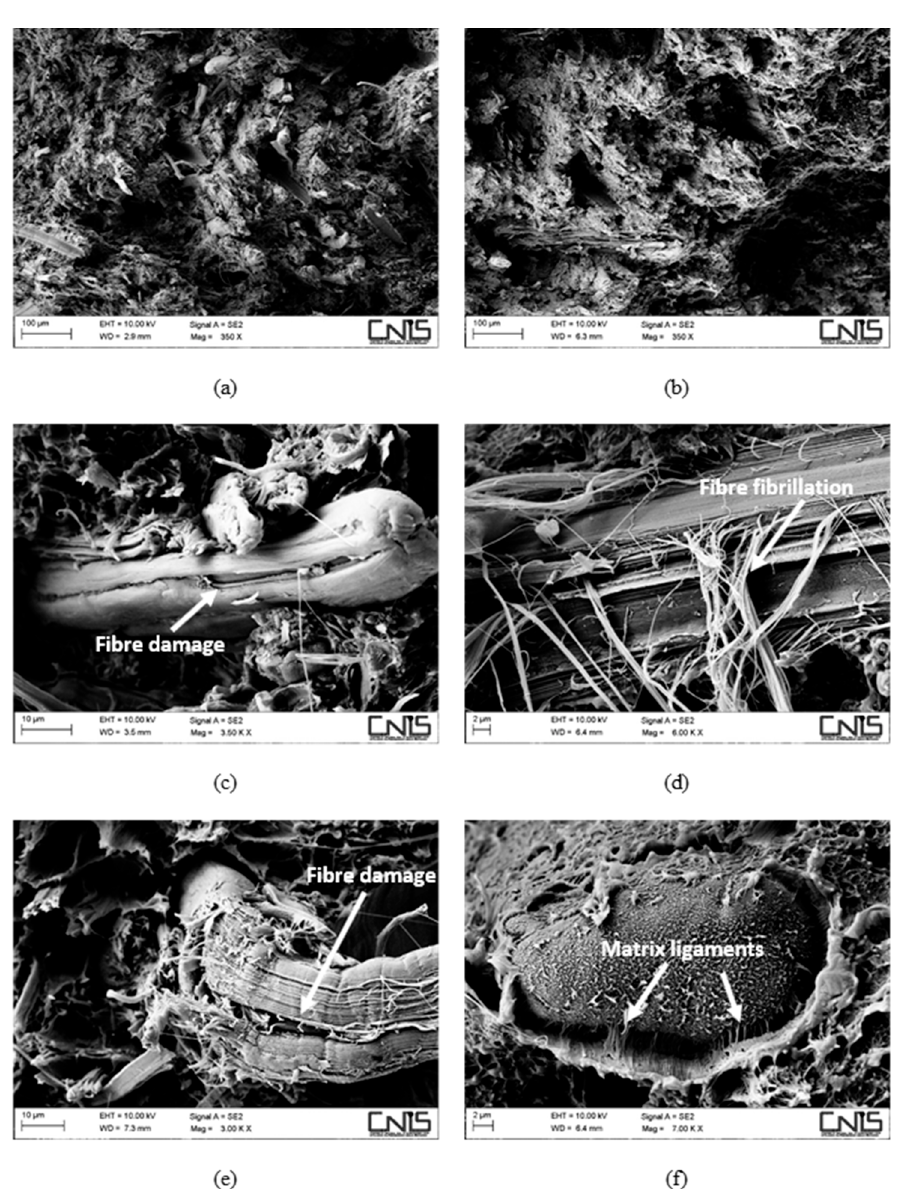
Figure 6. SEM micrographs detailing the fracture surface of aged composites, reinforced with 30 wt % of hemp fibres without ( a , c , e ) and with ( b , d , f ) a coupling agent.